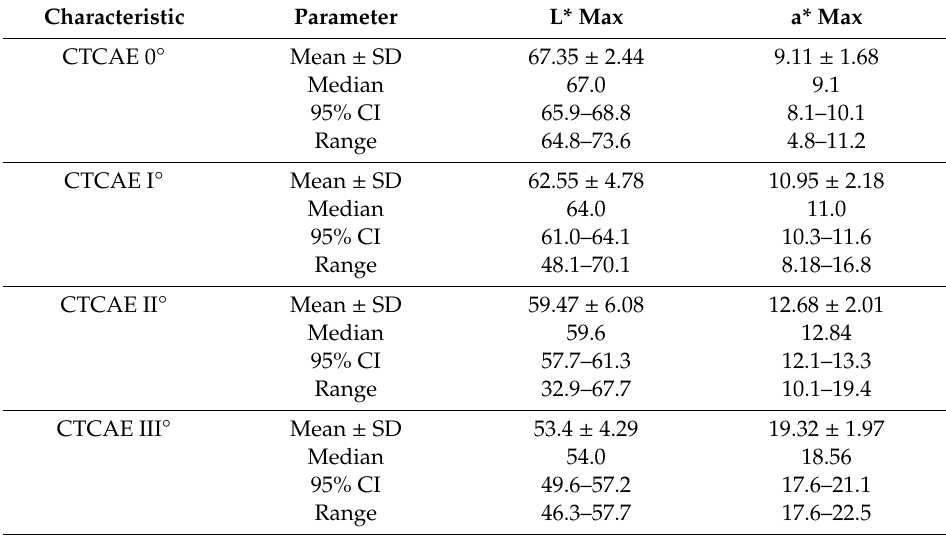
Table 2. Distribution of maximum L* and a* values for RID gradings according to CTCAE.